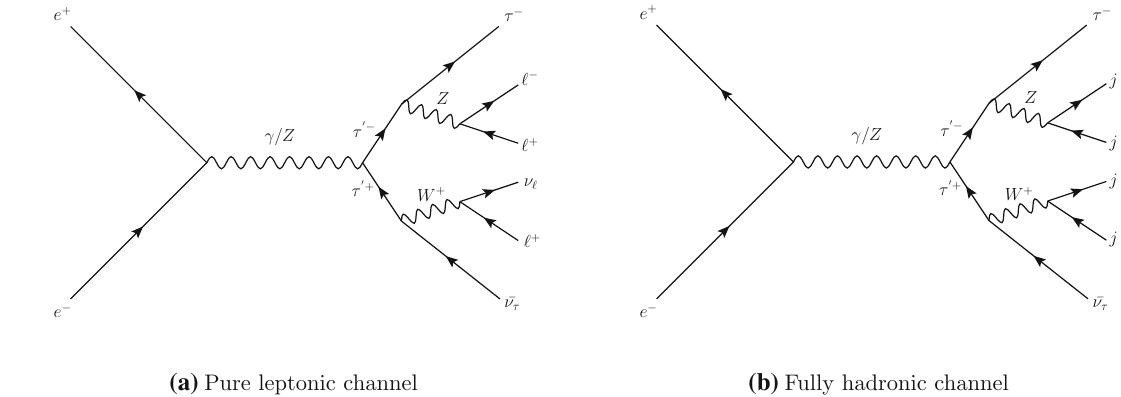
Fig. 6 The Feynman diagram of e + e − → τ (cid:2)+ τ (cid:2)− followed by the subsequent decay chains in pure leptonic chanel or fully hadronic channel